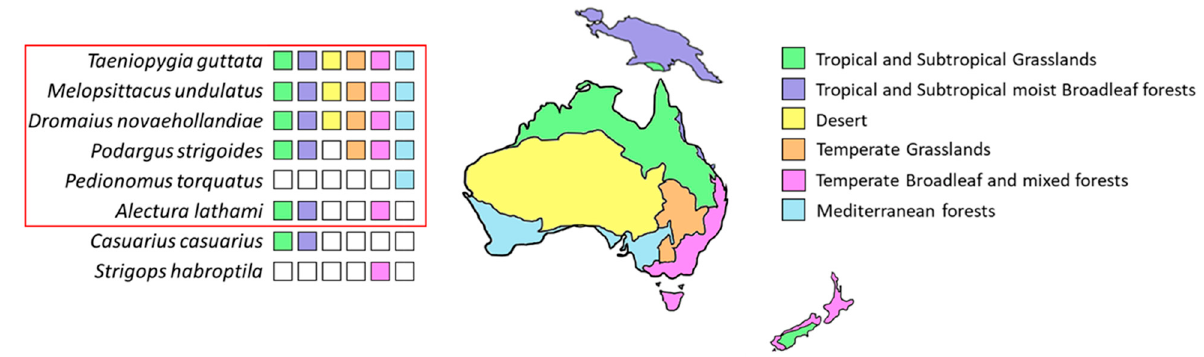
Figure 7. On the left side biome-related distribution is reported for eight species considered in this study. The red box groups the Australian species; C. casuarius is distributed in New Guinea and in York Peninsula (far North Queensland, Australia); S. habroptila is an endemic species of New Zealand. In the geographical map the biomes present in these areas are colored according to the legend.